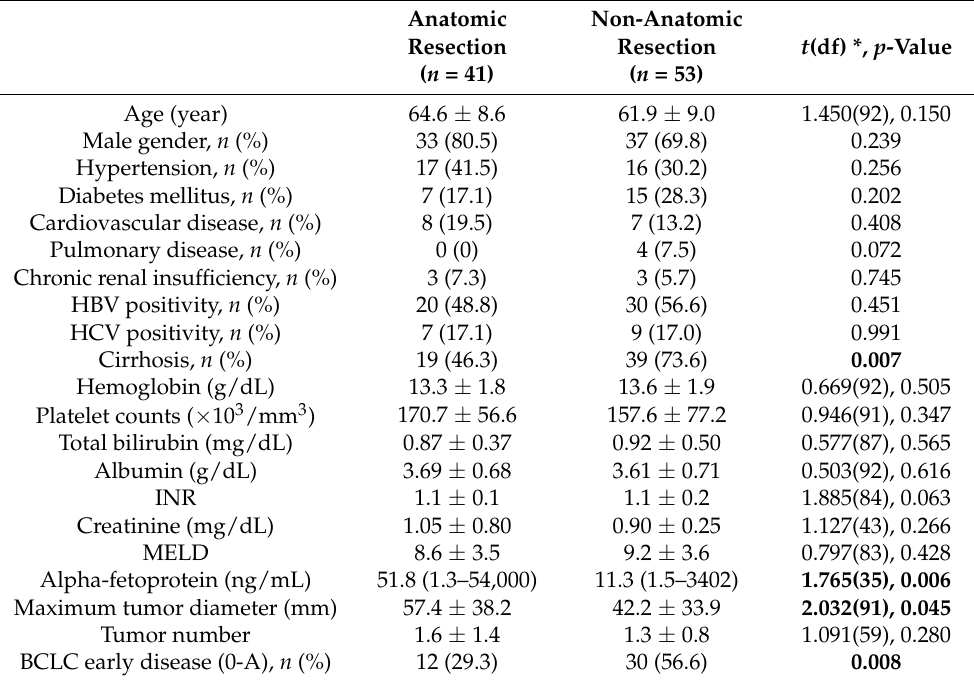
Table 1. Patient and disease characteristics, with comparisons between patients who underwent anatomic and non-anatomic